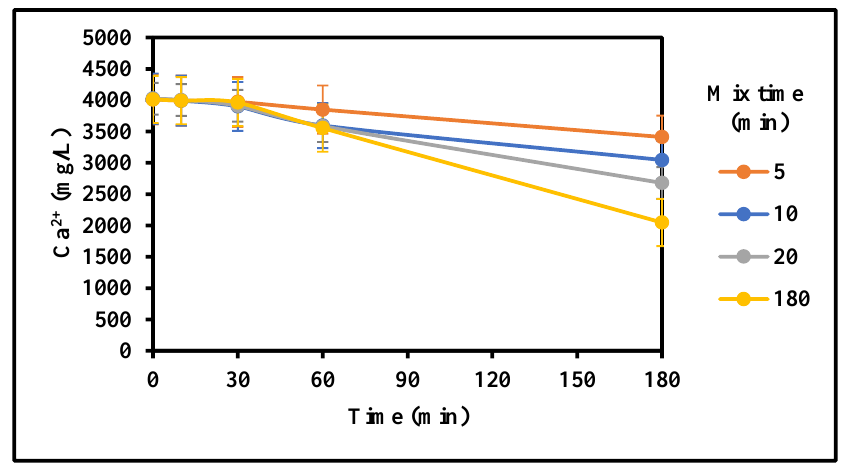
Figure 7. Effect of mixing time on the rate of gypsum crystallization with initial mixing (4000 mg/L CaSO 4 (as Ca), 0 g/L gypsum seed, 4 g/L Fe 3+ , 0 – 100 mg/L Inh. A, 25 °C, stirring rate: 200 rpm; Stirring time (min): 5 to 180/180).